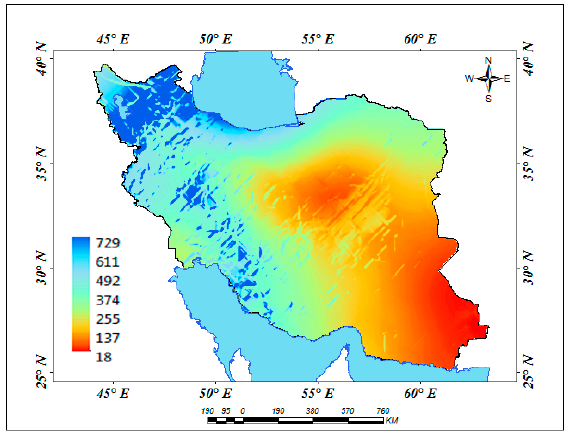
Figure 22. Forecasting of rainfall by using linear multi-regression.